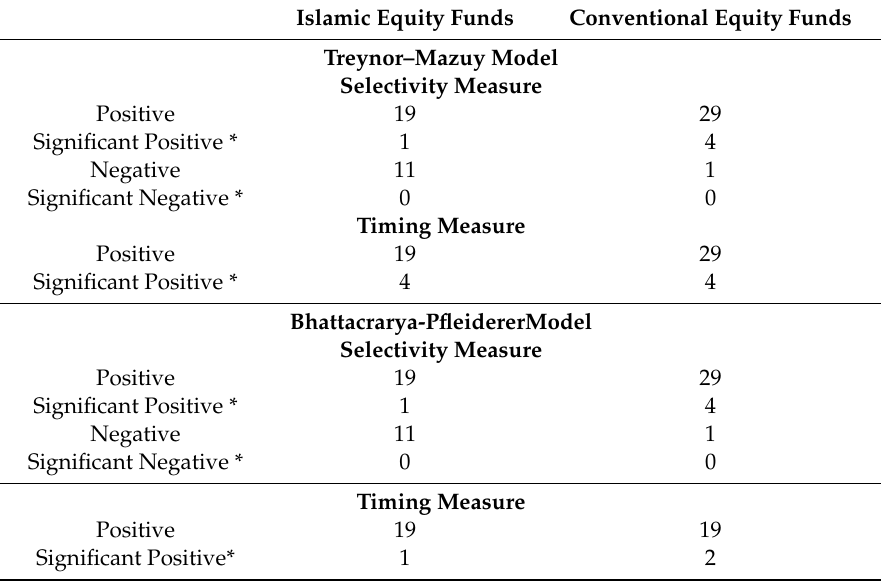
Table 2. Comparative Summary Statistics of Selectivity and Timing